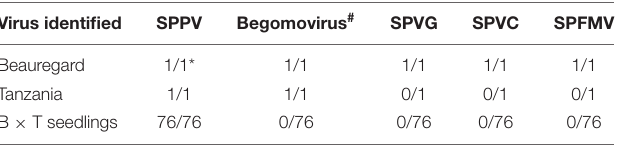
TABLE 4 | Results of PCR testing of in vitro germinated seedlings and their parents, Beauregard (B) and Tanzania (T). Virus identified